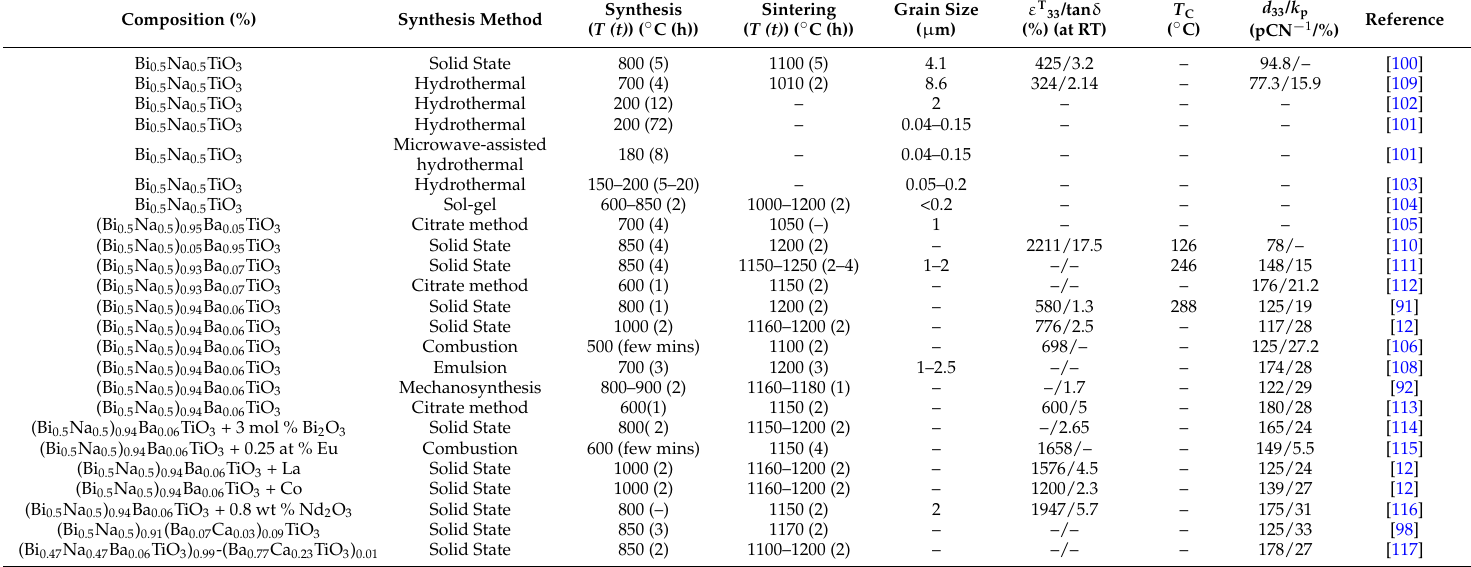
Table 2. Some results of the publications on compositions based on (Bi 0.5 Na 0.5 )TiO 3 -BaTiO 3